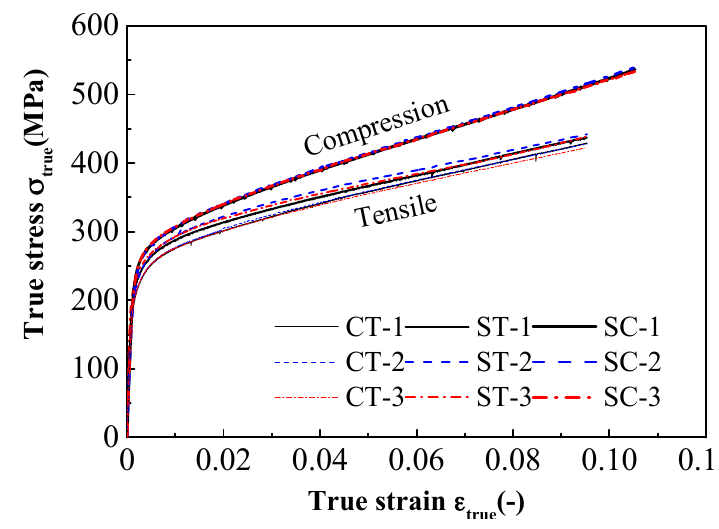
Figure 6. True stress-true strain curves for tensile and compression tests. (CT denotes tensile test of the conventional-gauge-length specimen, and ST and SC denote tensile test and compressive test of the small-gauge-length specimen). Table 3. Test results.